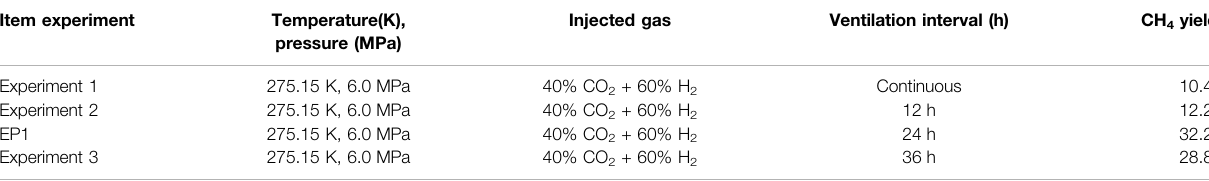
TABLE 4 | The contrast of replacement results in Experiment 1, 2, 3 and EP1.